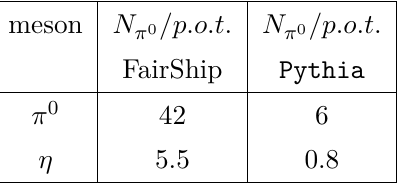
Table 2. Average particle multiplicities per p.o.t. in 400 GeV proton collisions as estimated with FairShip, applying a cut-off E 500 MeV on secondary particles, and with Pythia , for primary cut > interactions